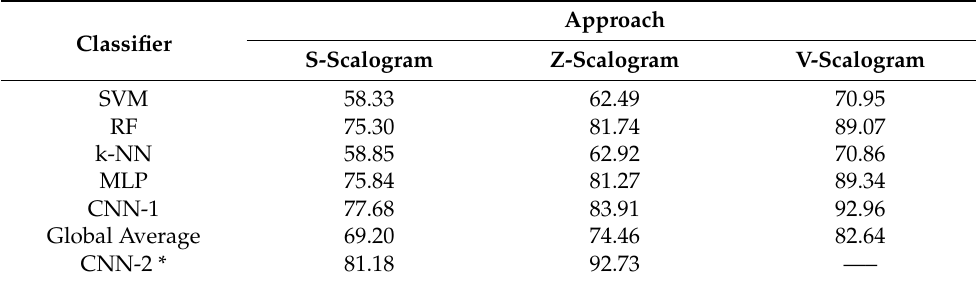
Table 2. Average classification accuracies of the six different types of classifiers across the entire test set consisting of 780,000 4-ERPs. The global average is the average of the column entries in the first five rows of the